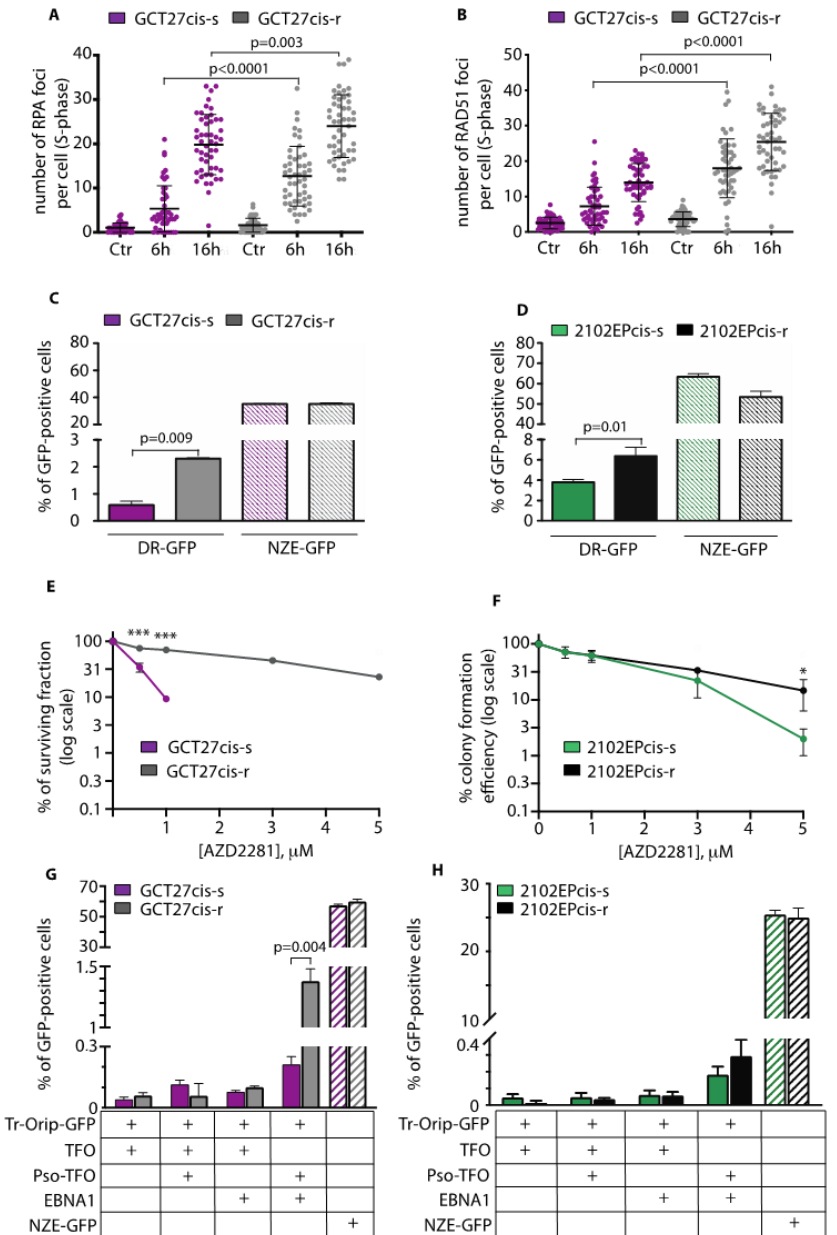
Figure 2. ( A , B ) Quantification of RPA and RAD51 foci numbers in BrdU-positive (S-phase) GCT27 paired cell lines, before (Ctr) and after treatment with 3 µ M cisplatin (6 h) and 16 h of culture in drug-free media. Data are mean values ± s.d. of three independent experiments. ( C , D ) Homology- direct repair proficiency of the indicated cell lines as measured by the DR-GFP assay. NZE-GFP is the plasmid used to measure transfection efficiency of each cell line. Data are mean values ± s.d. of two to three independent experiments. ( E , F ) Colony assay of the indicated cell lines upon chronic exposure to increasing doses of AZD2281. Data are mean values ± s.d. of five